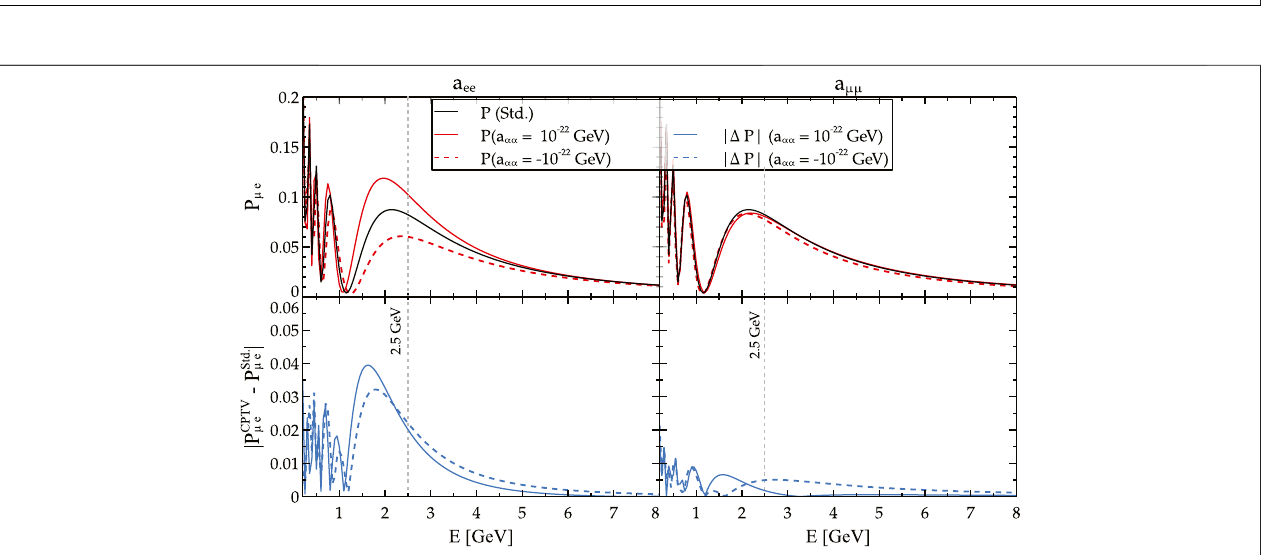
FIGURE 4 | Same results as in Figure 3 , now for the diagonal parameters in the electron and muon sectors. Notice, however, that the benchmark values used for the diagonal CPT – violating parameters here are fi ve times larger than the ones assumed in Figure 3 . Still, the level of sensitive is